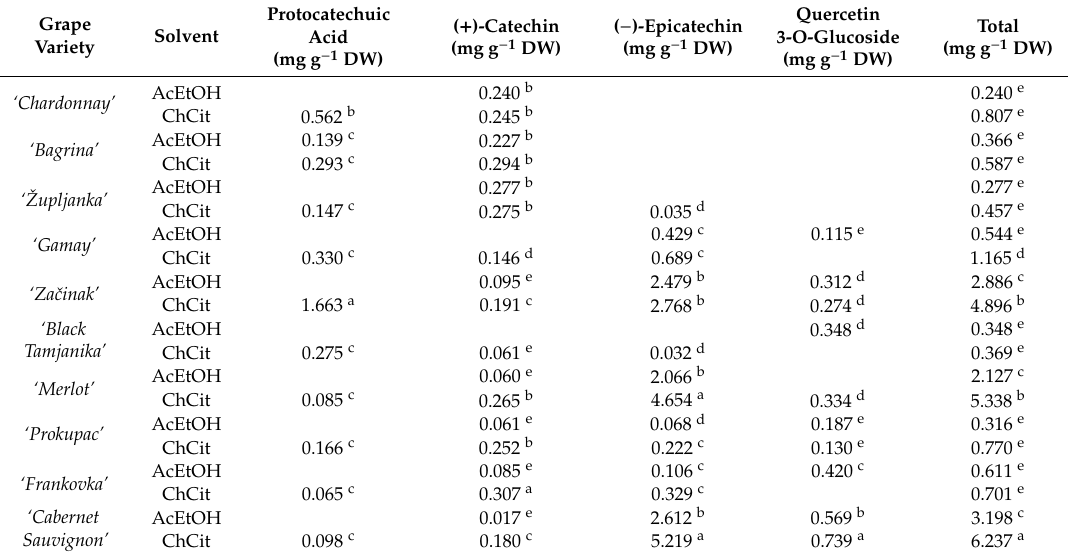
Table 4. Phenolic composition of grape skin